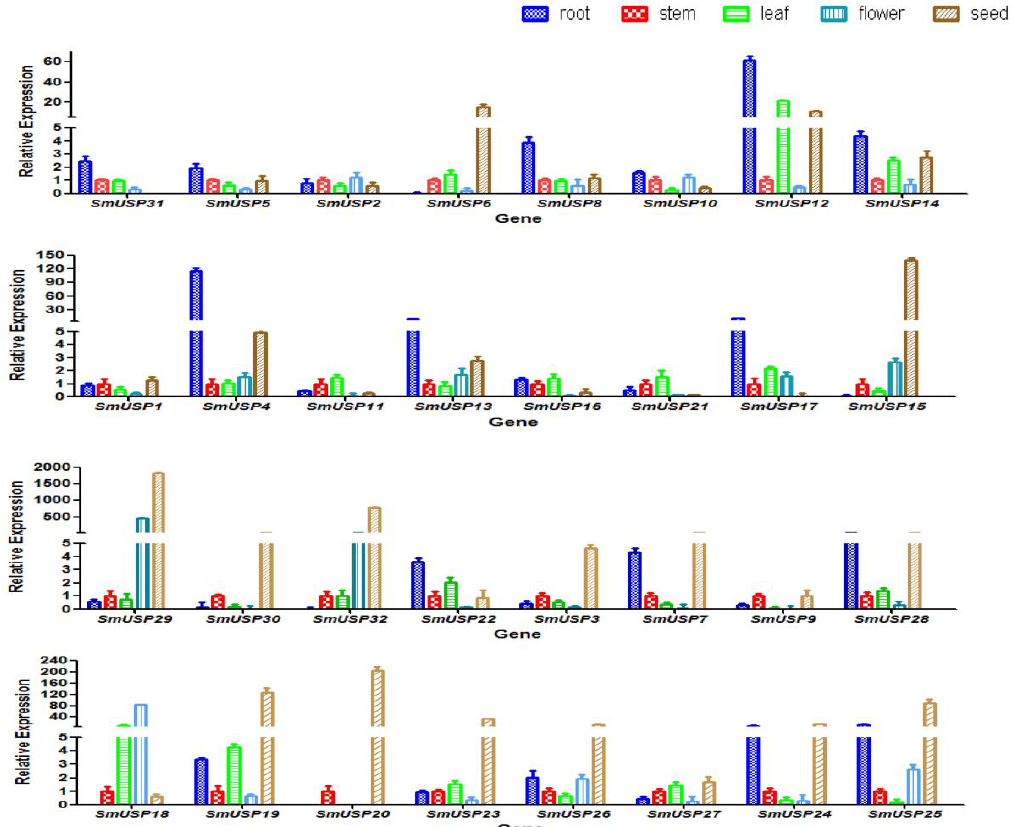
Figure 5. Expression patterns of 32 SmUSP genes in different tissues/organs. Transcription levels were analyzed according to comparative 2 −ΔΔC(T) method; all expression levels are relative to that detected in stem samples because all 32 SmUSPs expressed in stem . All data were presented as the means ± Standard Deviation (SD) of at least three